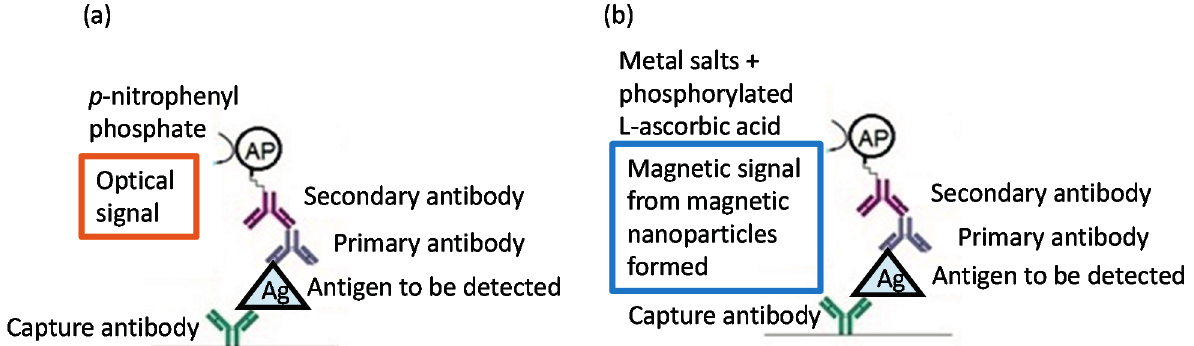
Figure 1. ( a ) Conventional ELISA—detection by optical signal ( b ) our novel strategy—detection by magnetic signal. Figure adapted from